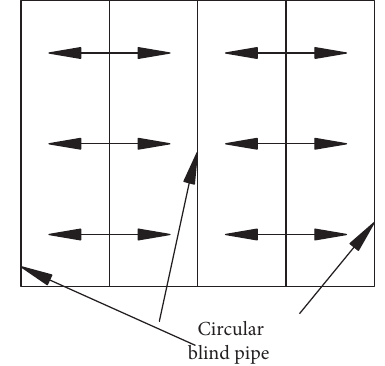
Figure 2: Working principle of the circular blind